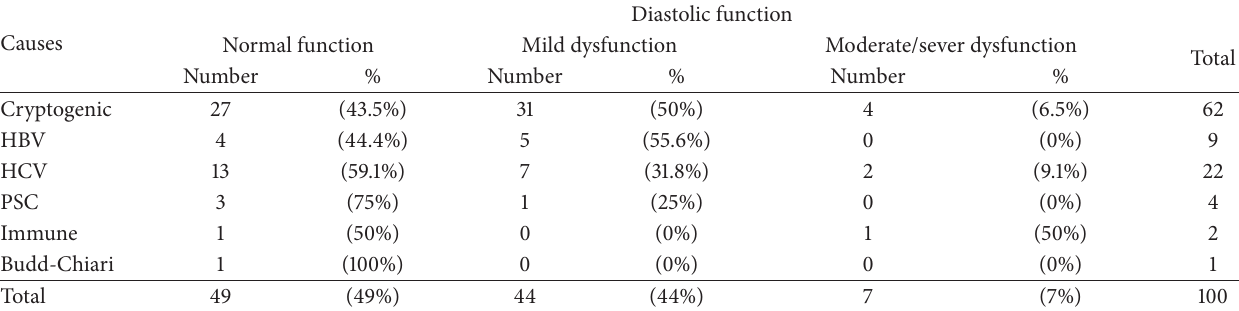
Table 7: Distribution of diastolic function between various causes of